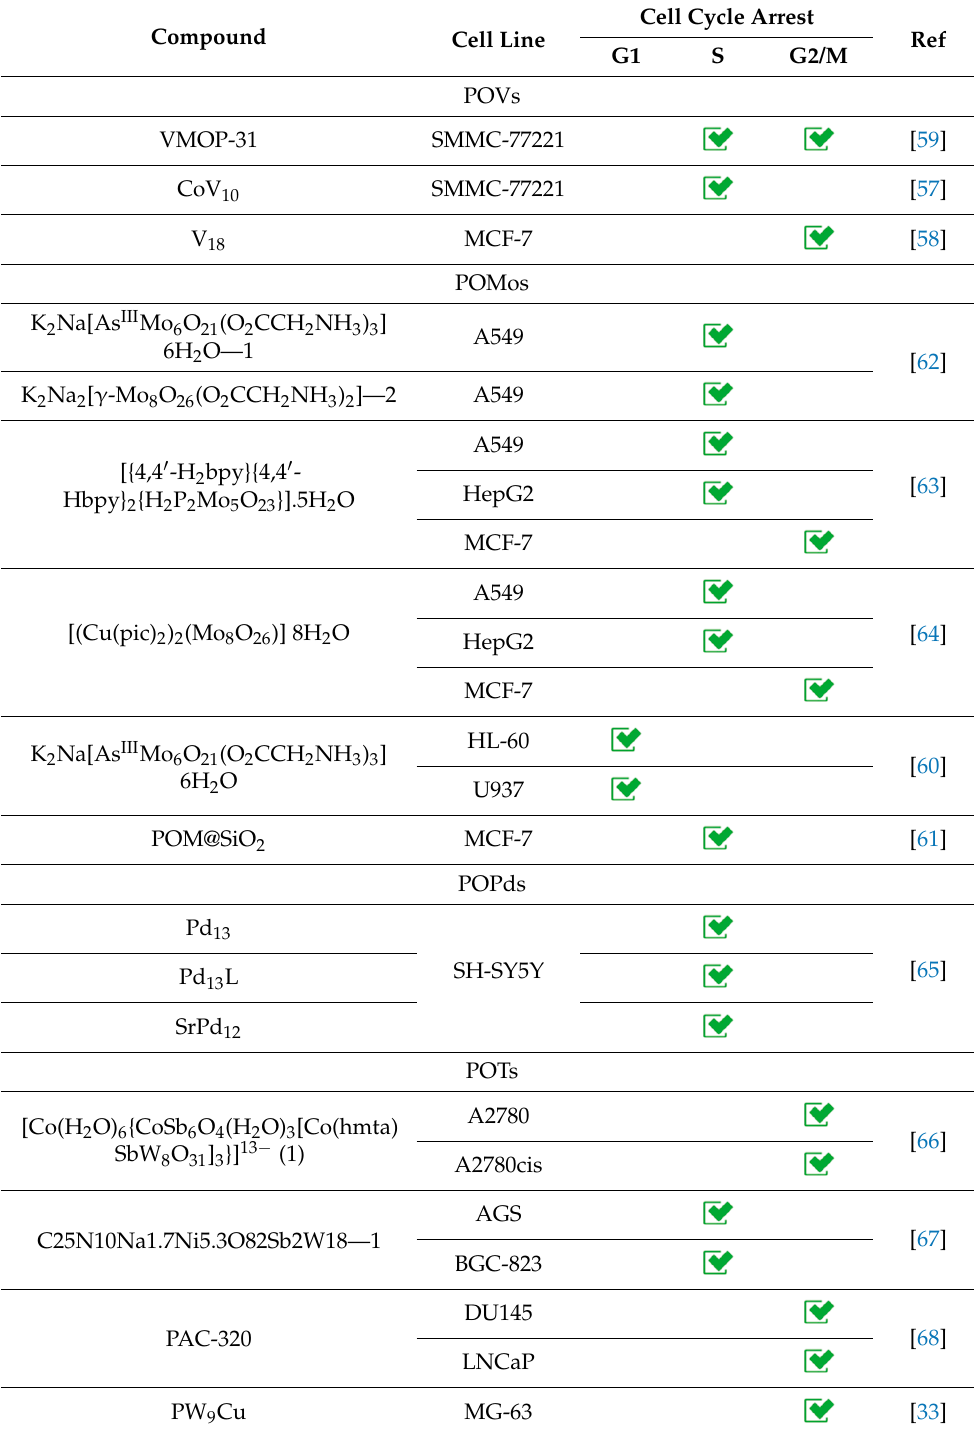
Table 4. Effect of POMs and their cell lines on cell cycle arrest.